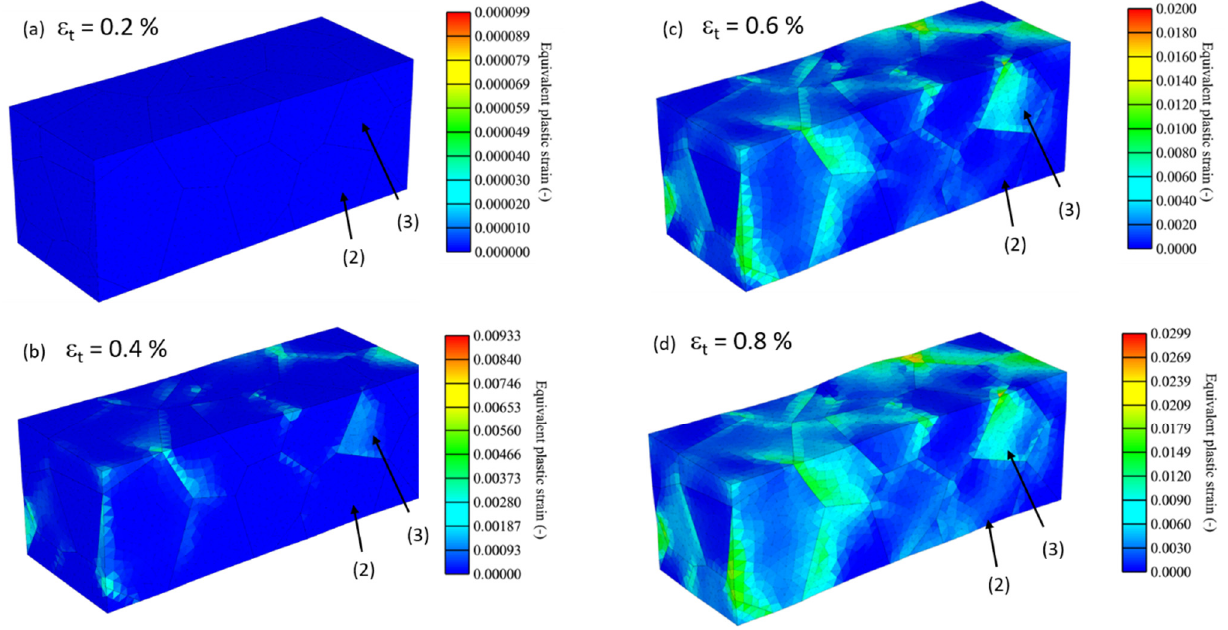
Figure 6. Distribution of equivalent plastic strain under ( a ) 0.2%, ( b ) 0.4%, ( c ) 0.6% and ( d ) 0.8% total strain for the randomly orientated grain distribution.